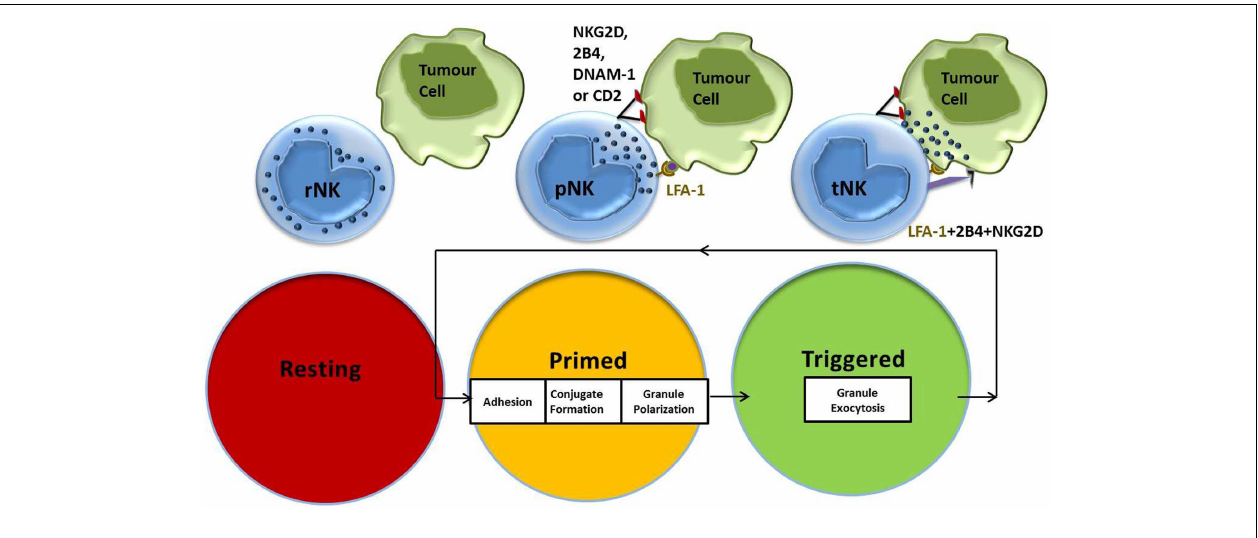
necessary to induce adhesion, conjugate formation, and granule polarization. Co-stimulation of additional NK cell activating receptors by the triggering ligands results in NK cell-mediated cytotoxicity against target